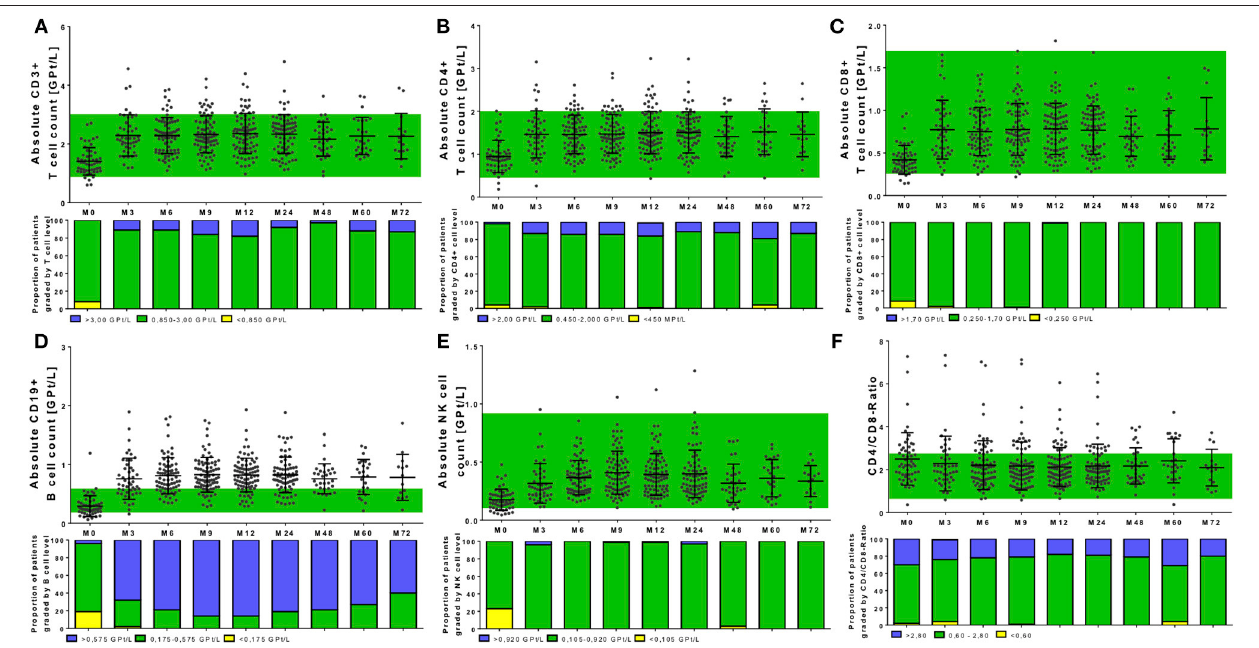
FIGURE 4 | Cell count of selective immune cell subpopulations during NAT treatment. Absolute cell count of CD3 + T cells (A) , CD4 + T cells (B) , CD8 + T cells (C) , CD19 + B cells (D) , NK cells (E) , and the CD4 + /CD8 + -Ratio (F) are depicted. Data are shown for baseline analysis (M0), month 3 (M3), month 6 (M6), month 12 (M12), and every 12 months follow up (M24, M48, M60, M72). Mean ± standard deviation are presented. Green background indicates reference range of depicted parameters. Additionally, proportion of patients graded by lymphocyte subtype level are shown: lower than reference range (yellow), reference range (green) and higher than the reference range (blue). Level of significance are presented in Table 2